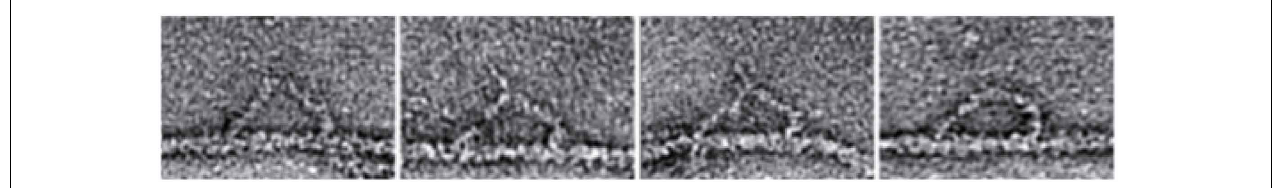
FIGURE 8 | Myosin V molecules trapped in the actin of moving along actin. Negatively stained electron micrograph of myosin V bound to actin in the presence of ATP. In each panel, the two heads of myosin are seen to bind to actin separated by 36nm. Image is taken from Walker et al. (2000).